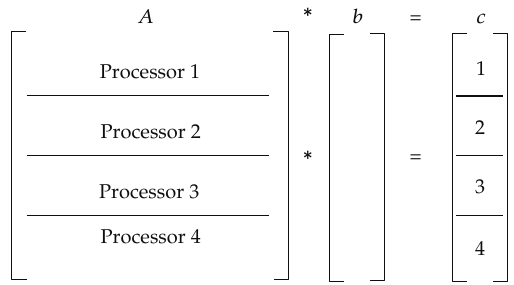
Figure 3: Matrix-vector product of a matrix distributed by rows.